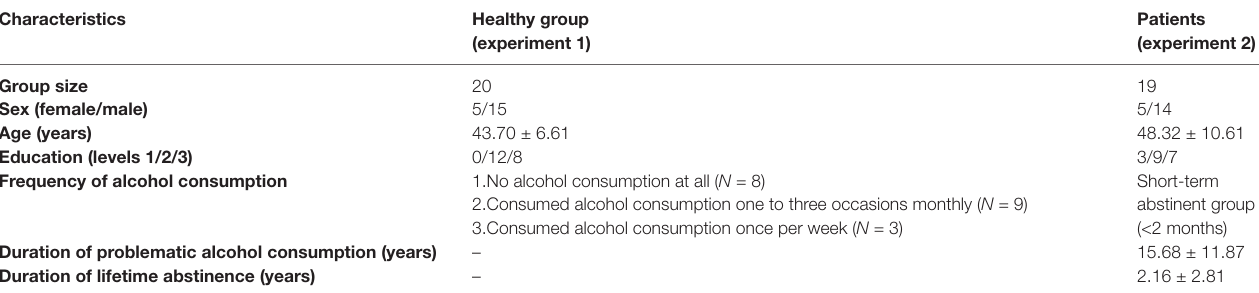
TABLE 1 | Demographic and clinical characteristics of